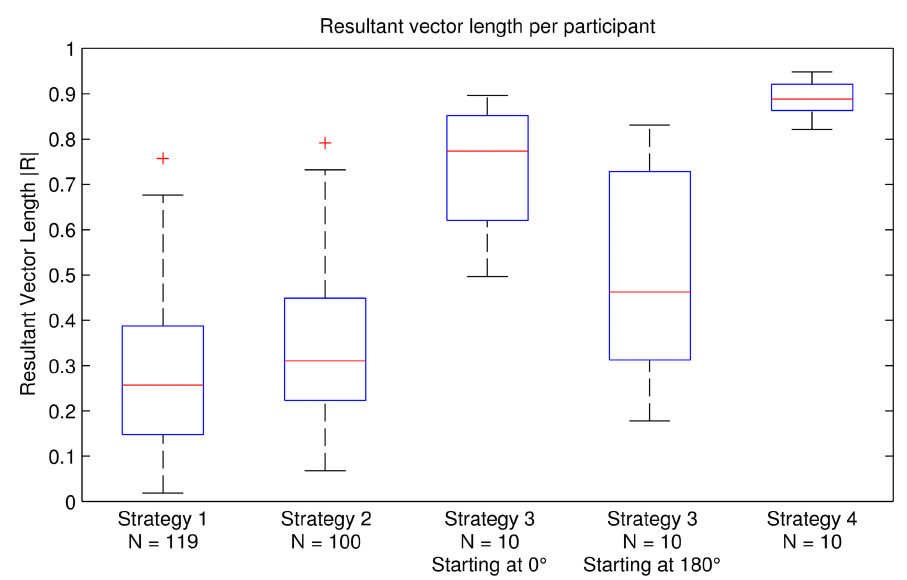
Fig. 6. Resultant vector lengths of individual participants for all alignment